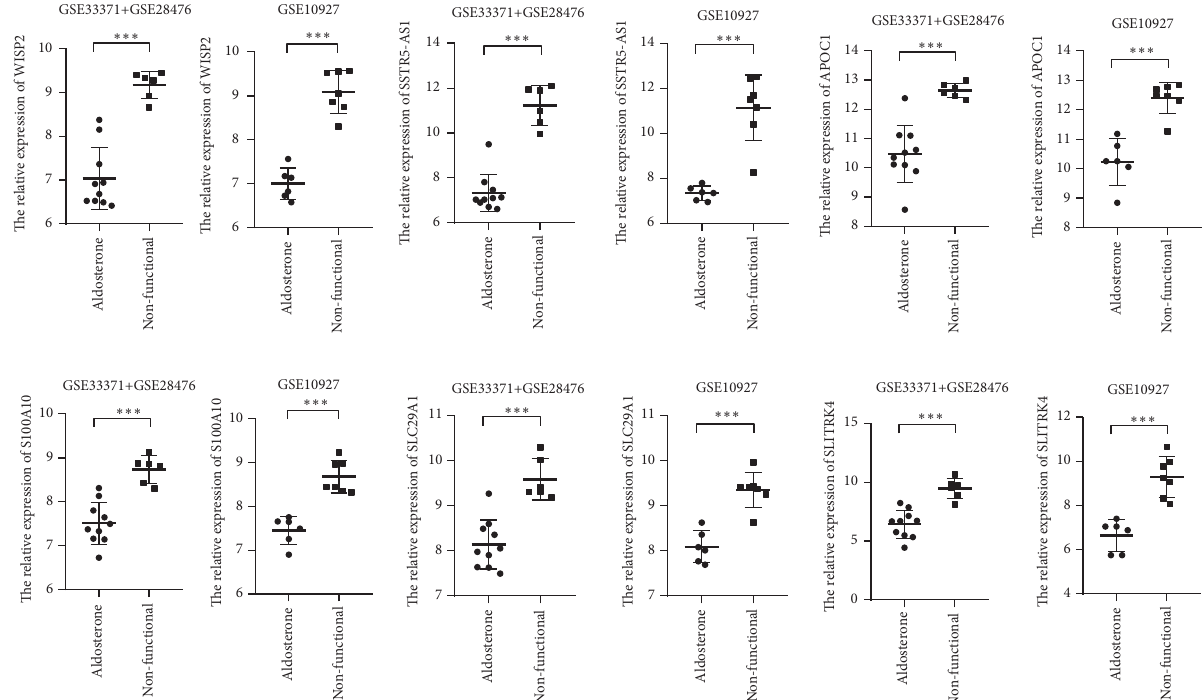
Figure 8: Validation of the expression pattern of real hub genes between the combined datasets (GSE333714 and GSE28476) and the validation dataset (GSE10927). Six genes, including one lncRNA gene, were found to have the same expression pattern between the combined and validation datasets. In addition, all of these genes were poorly expressed in the APA samples compared to the NFAA samples. The three asterisks represent P values < 0.001 between the two groups.